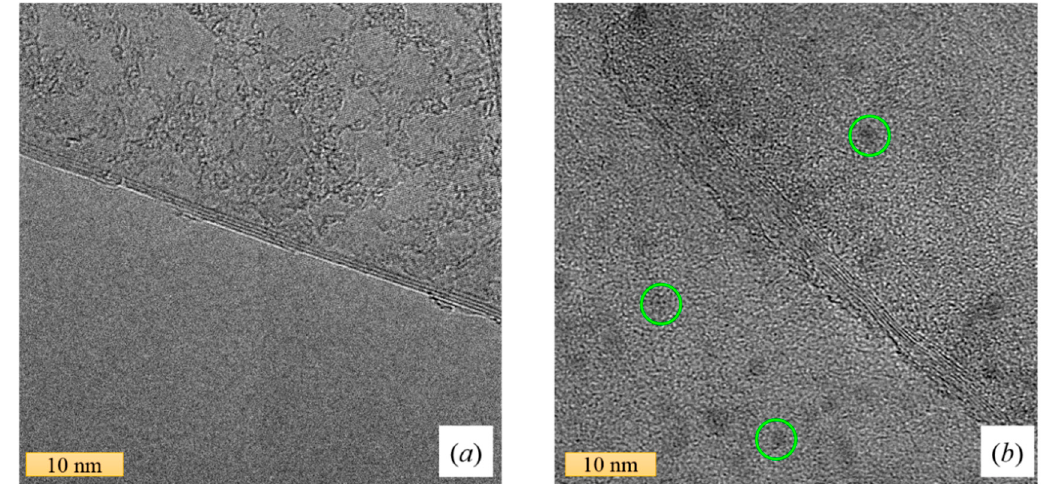
Figure 5. Representative transmission electron microscopy (TEM) images of graphene from: ( a ) a DMAc dispersion and ( b ) an NMP dispersion. Both images show the multilayer nature of the flakes folded graphene sheets. Highlighted by green circles, some nanoparticulates can be observed in the NMP-based nanofluid.